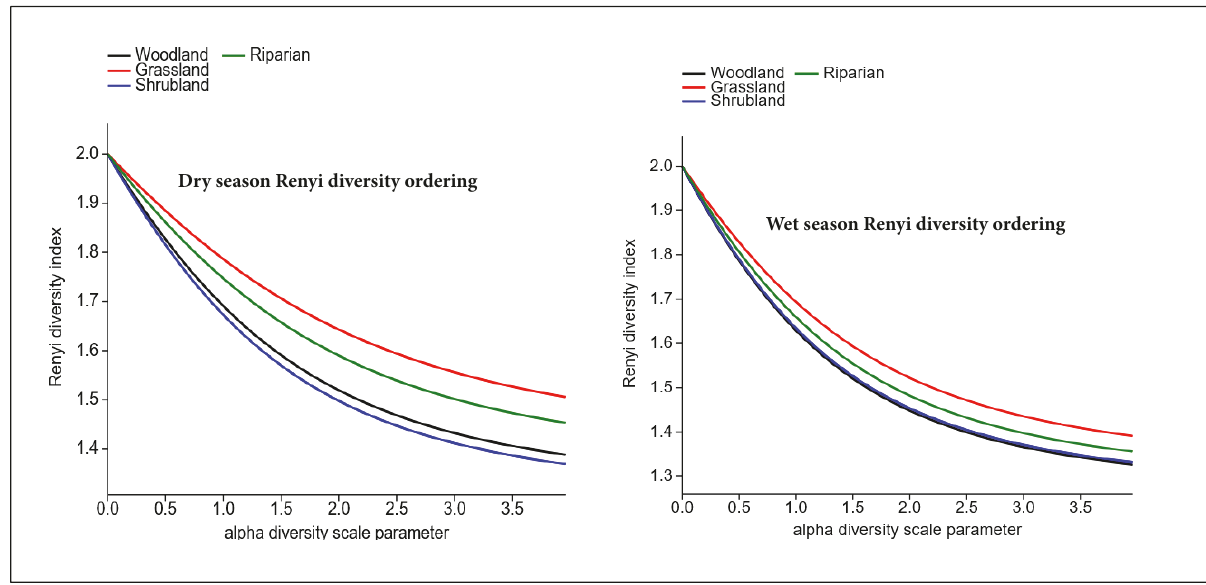
Figure 5: Renyi diversity ordering that compares bird evenness and richness for the dry and wet seasons, across the four habitats. Notice that the shape of the curve of each habitat is an indication of their spatial evenness of species and ordered from the lowest to highest